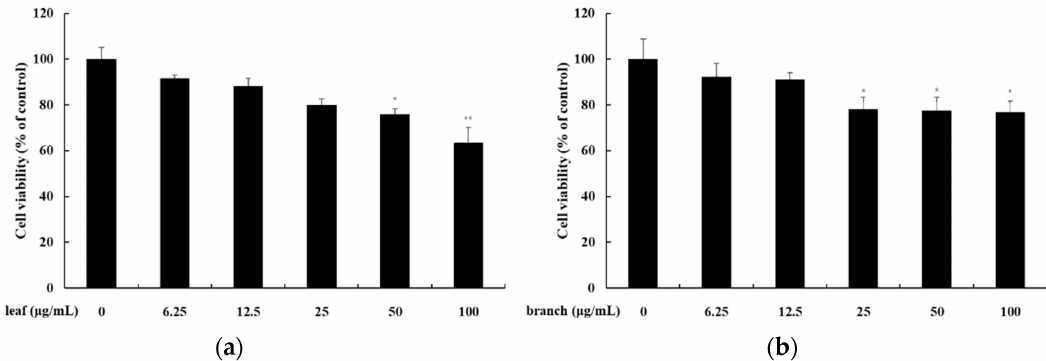
Figure 8. The e ff ect of hot-water extracts from S. samarangense on the viability of HaCaT (human keratinocyte cells). Cells were each treated with ( a ) the leaf of S. samarangense (6.25, 12.5, 25, 50, and 100 µ g / mL) and ( b ) the branch of S. samarangense (6.25, 12.5, 25, 50, and 100 µ g / mL) for 24 h. The cell